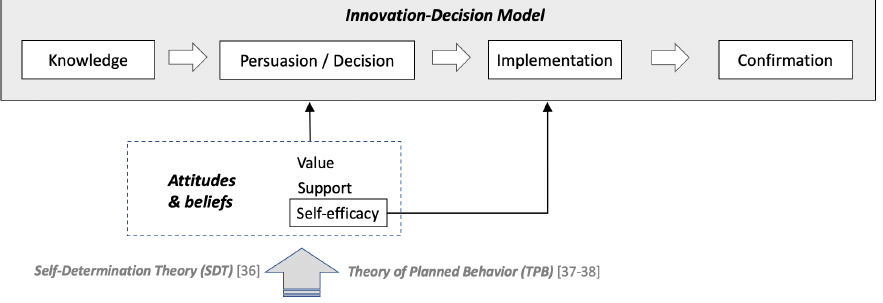
FIG. 1. The innovation-decision model [2,28]; dotted lines indicate contributing factors to the ID